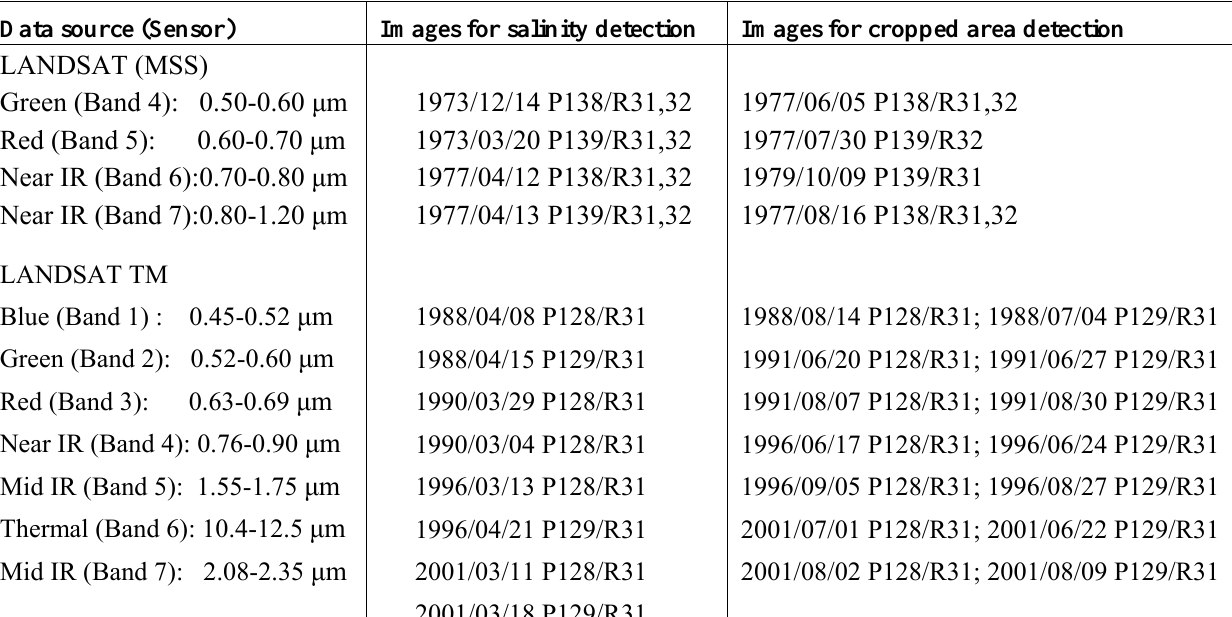
Table 1. The images used in this